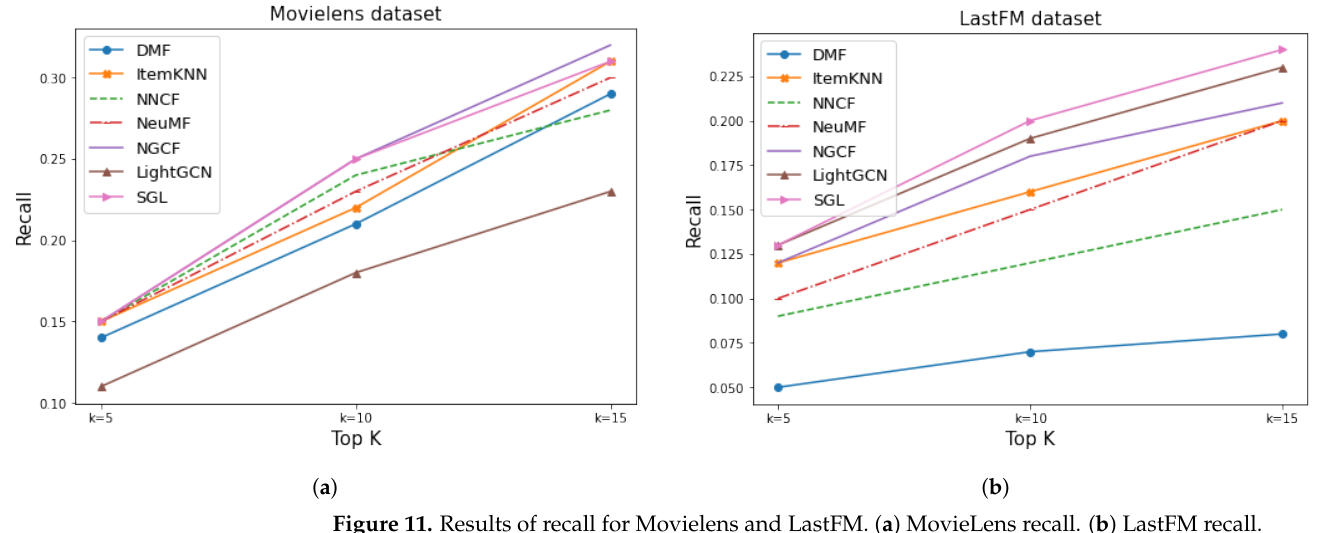
Figure 11. Results of recall for Movielens and LastFM. ( a ) MovieLens recall. ( b ) LastFM recall.